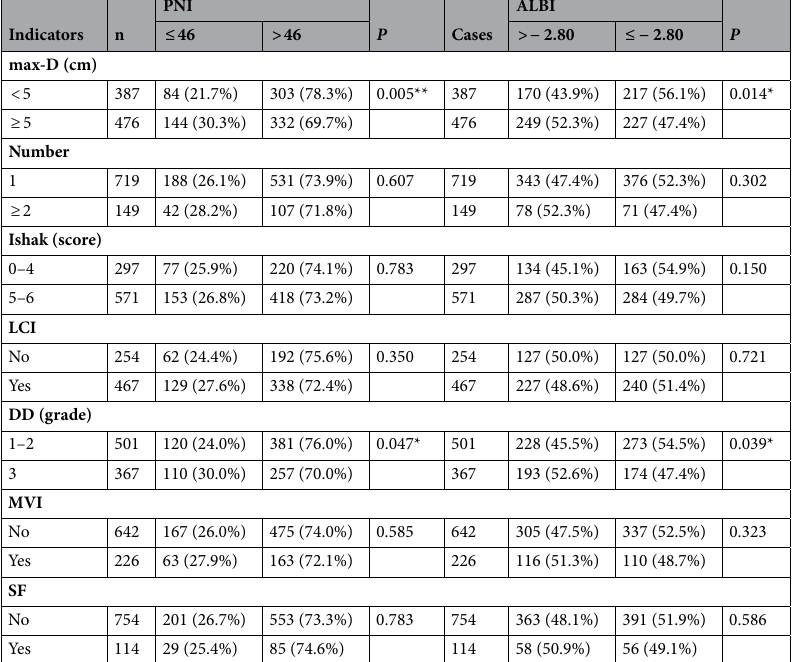
Based on Fig. 4, the optimal cut-off value of XPI was 75.0, sensitivity = 0.825, specificity = 0.279, correspond- ing to maximum Youden index (= 0.104) for predicting 5-year OS in ROC analysis. Therefore, the patients were divided into the XPI-high (ALBI > 75) group or XPI-low (PNI ≤ 75) group. In contrast with the XPI-low group, the XPI-high group had significantly higher 1-, 3-, and 5-year OS (87.9% vs 82.0%, 66.9% vs 54.7% and 53.7% vs 37.2%, respectively, P < 0.01) (Fig. 3c) and 1-, 3-, and 5-year DFS (67.6% vs 61.4% and 46.3% vs 36.2%, 35.4% and 22.9%, respectively, P < 0.01) (Fig. 3d). This suggests that XPI is positively correlated with survival rate in HBV-HCC patients undergoing RH. Multivariate analysis was performed to establish the predictive models for DFS and OS of HBV-HCC patients undergoing RH. After adjustment of hazard ratio (HR) by multivariate analysis, PNI-ALBI (in Model 3) and XPI (in Model 4) could independently predict OS (all P < 0.01) and DFS (all P < 0.05) (Table 5). Discussion